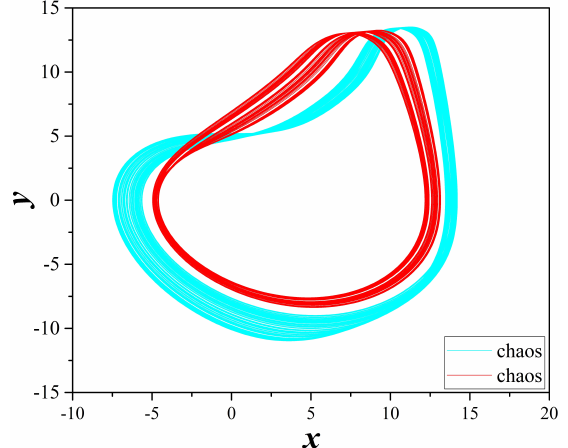
Figure 17. Coexisting attractors of system (2), for a = 4 × 10 − 4 , b = 1, c = 3.846 × 10 − 4 , d = 1 and e = 1.20. With cyan color and for ( x 0 , y 0 , z 0 ) = ( 0,0.1,0 ) a period-2 attractor, while with red color and ( x 0 , y 0 , z 0 ) = ( − 4.7922951,0,4.3626296 ) a period-4 attractor.